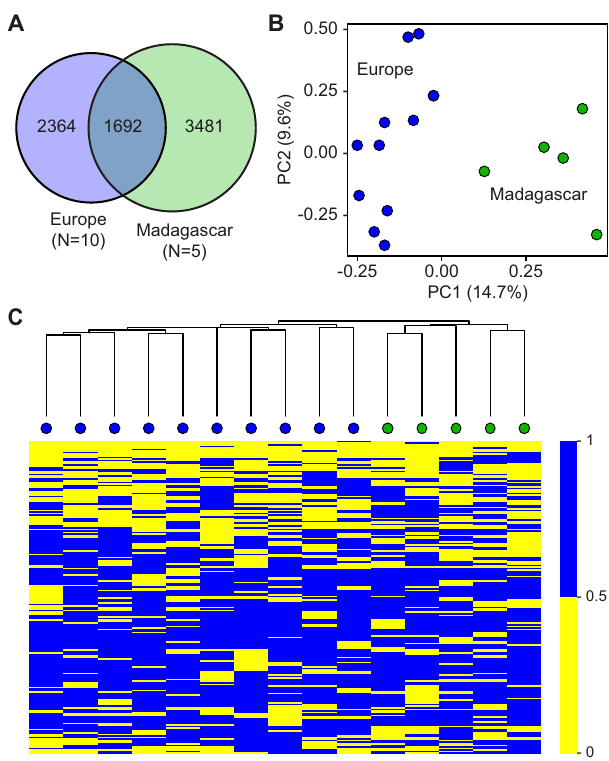
Fig. 4 Comparison of European and Malagasy populations, based on common genetic variants. A Venn diagram demonstrating the level of overlap of shared single-nucleotide variants (SNVs) between the European and Malagasy populations. B Principal component analysis (PCA) of representative specimens from ten European and fi ve Malagasy populations. C Heatmap of SNV patterns, based on the 8912 common polymorphic sites. The color represents the average number of SNVs per site, as indicated. The clustering re fl ects the speci fi c geographical SNV